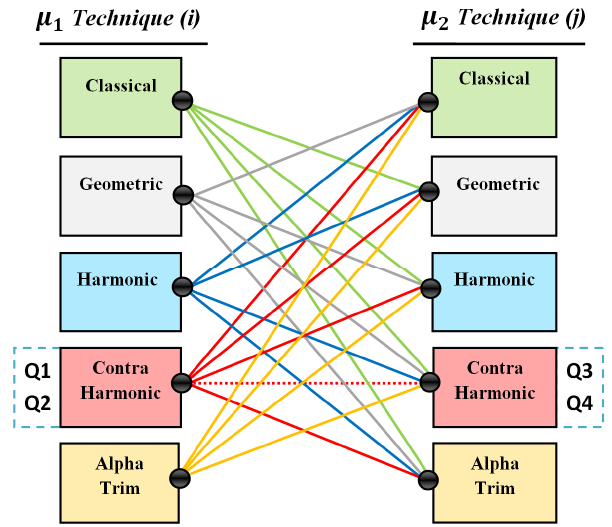
Figure 3. Proposed heterogeneous mean filter model for Figure 2, where i ≠ j .